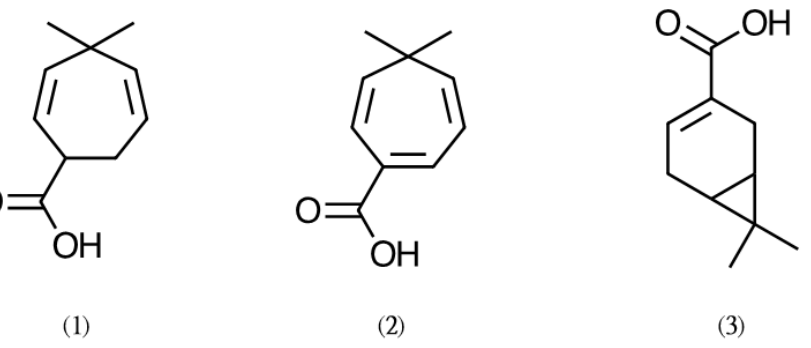
Figure 4. Chemical structures of three index compounds ( 1 ) Shonanic acid, ( 2 ) Thujic acid, and ( 3 ) Chaminic acid.